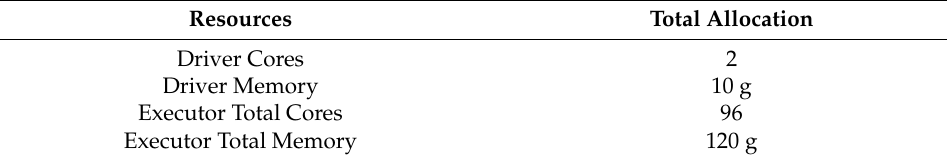
Table 18. Spark’s optimum resource settings and total allocation .